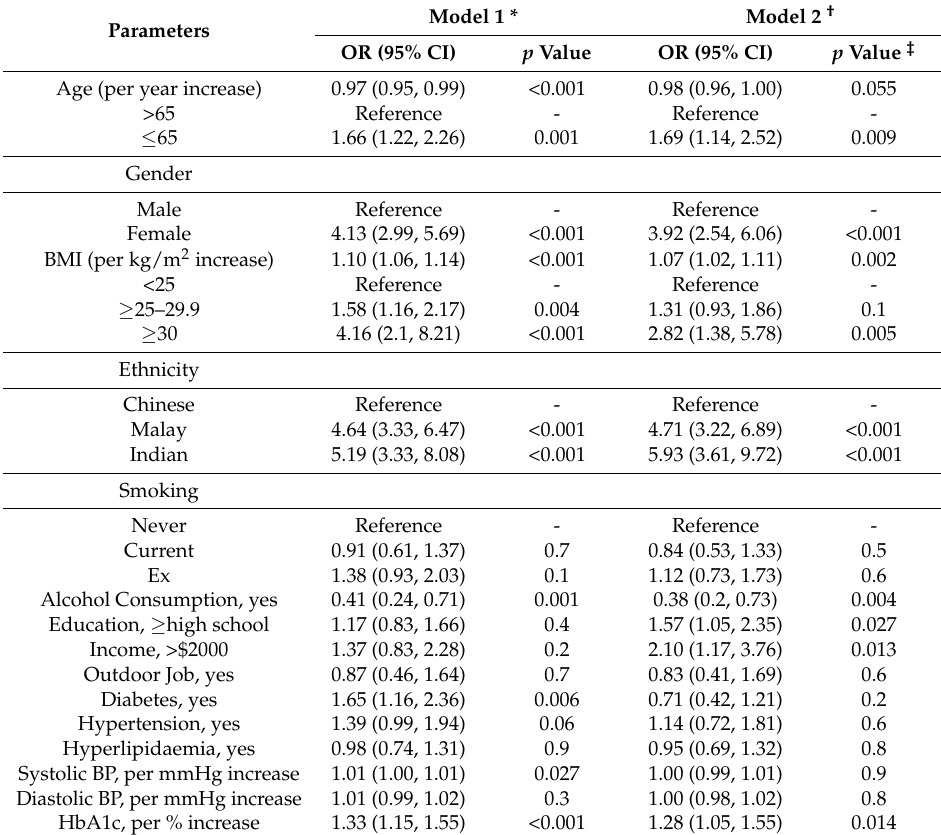
Figure 1. Bar graph showing 25(OH)D status by gender and ethnicity. Table 2. Associations Of clinical and demographic variables with suboptimal 25(OH)D concentration.